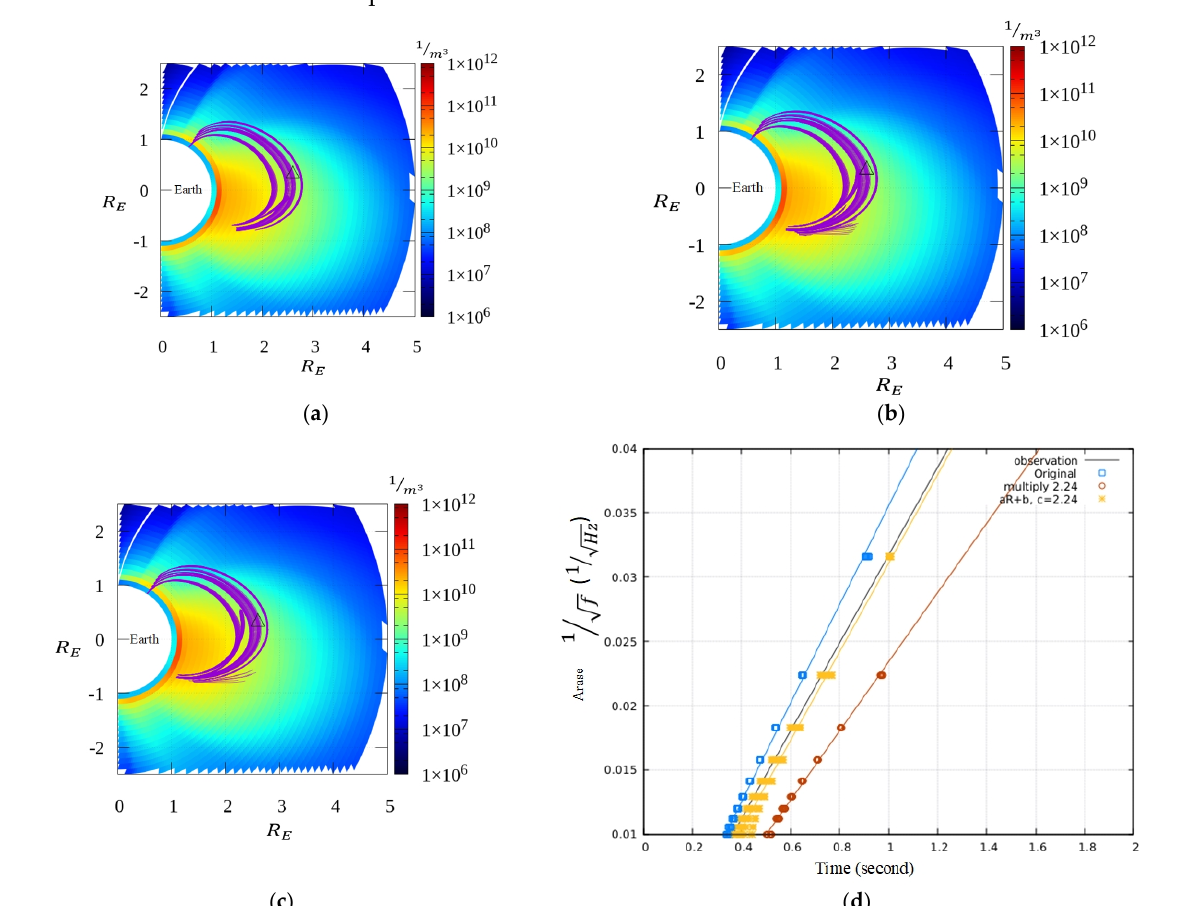
Figure 10. Simulation results. Ray path simulation using the density modified by Equation (6) for frequency: ( a ) 5 kHz, ( b ) 8 kHz, ( c ) 10 kHz. ( d ) The calculated propagation times from the source point with Arase location for the first event; gray line shows the dispersion measured by Arase; blue line shows the calculated dispersion using the reference electron density profile; orange line shows the calculated dispersion using the modified electron density with constant 𝑐 , yellow line shows the calculated dispersion using the modified electron density using Equation (6).